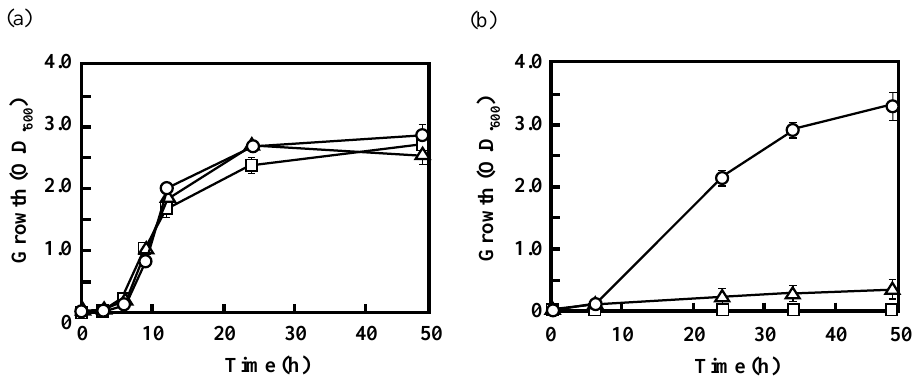
Figure 4. Growth of C. freundii IFO 13545 and its acs and aceA disruptants ( Δ acs and Δ aceA ) on: glucose ( a ); and acetate ( b ). Symbols: circles, IFO 13545 (wild type); triangles, Δ acs ; squares, Δ aceA . This experiment was conducted in triplicate; the averages ± standard deviations of the values obtained are shown.